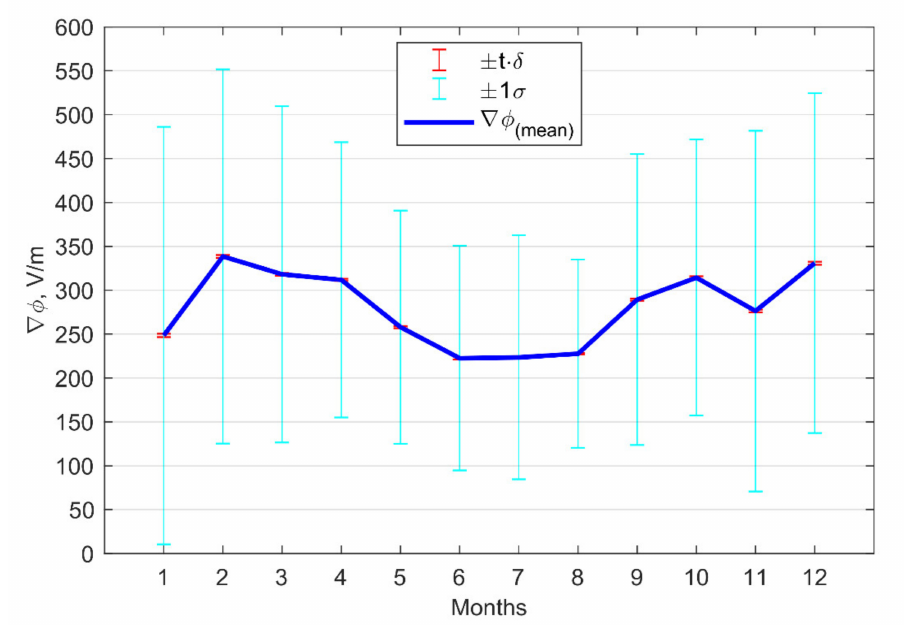
Figure 5. Seasonal variation in the potential gradient obtained under fair-weather conditions in Tomsk. In the figure, the width of the confidence interval ± t · δ is determined by the multiplication of the Student’s t -value ( t ) and the standard error of the mean ( δ = σ / N—sample length), and ± 1 σ —the range equal to one standard